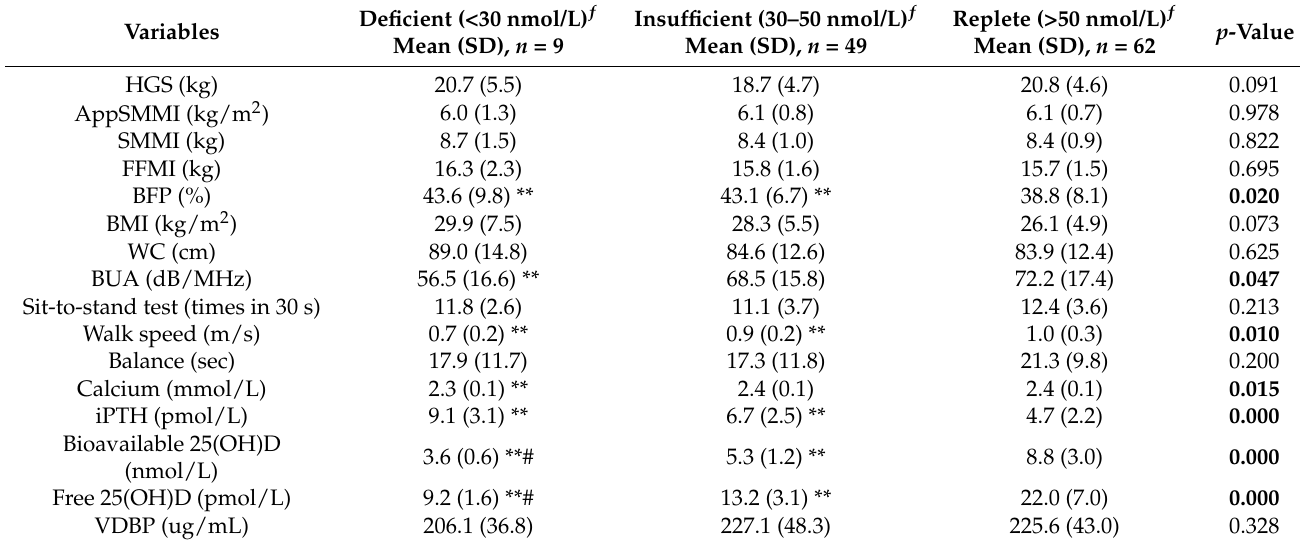
Table 3. The differences in characteristics for participants who were Vitamin D (Total 25(OH)D) deficient, insufficient, and replete.